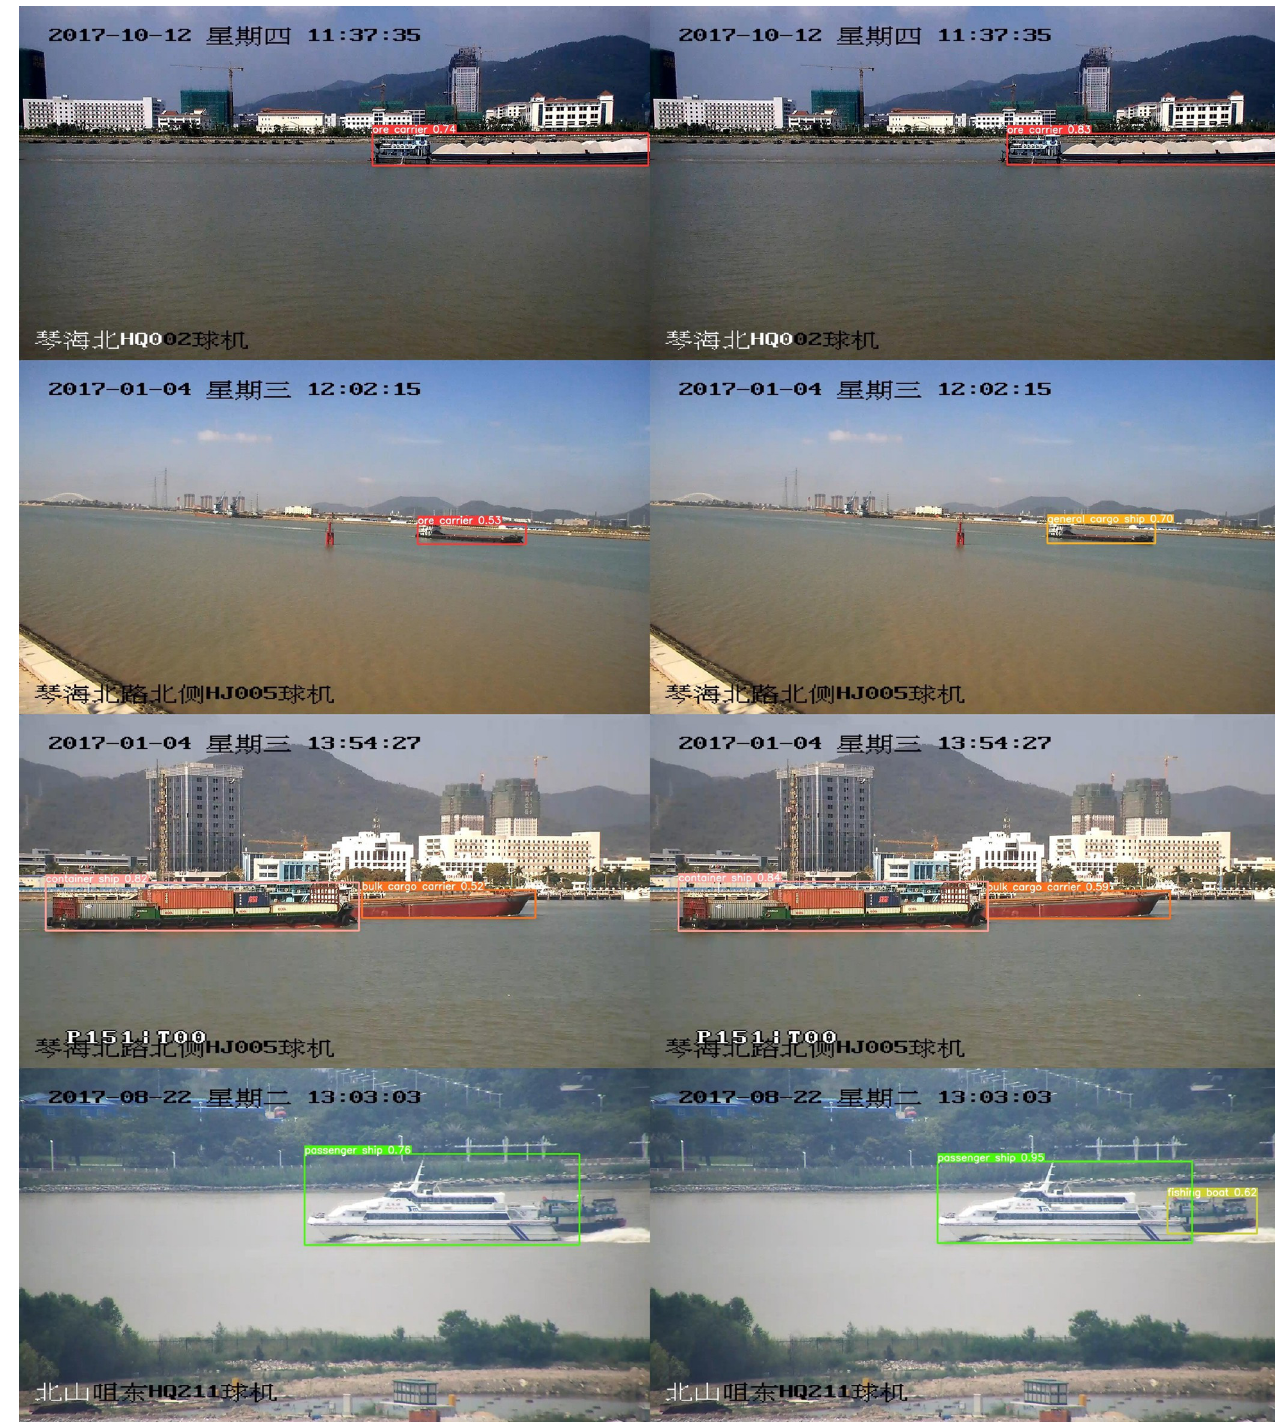
Fig 16. Comparison of YOLOv5s and MC-YOLOv5s in the test set visuals. (a) YOLOv5s (b) MC-YOLOv5s.